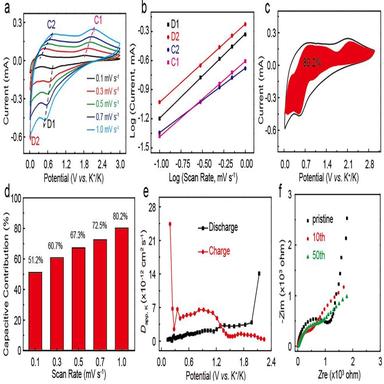
(a) The CV curves of G@PSC at various scan rates from 0.1 to 1 mV s1 in KIBs. (b) The b values by plotting peak current and scan rate. (c) Capacitive contribution at the scan rate of 1 mV s1 . (d) Capacitive-controlled contribution ratios at different scan rates. (e) The apparent K+ -diffusion coefficients of G@PSC calculated from GITT. (f) The EIS spectra of G@PSC at different cycles at 0.1 A g1 .